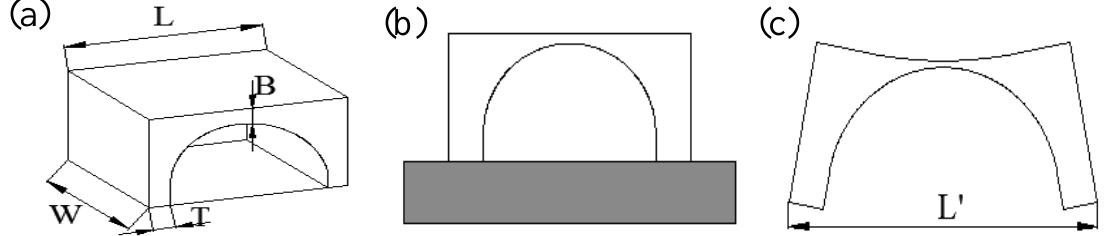
Figure 4. Schematic of bridge structure designing: ( a ) 3D design model of the part; ( b ) placement and manufacturing of parts; ( c ) schematic of parts deformation.